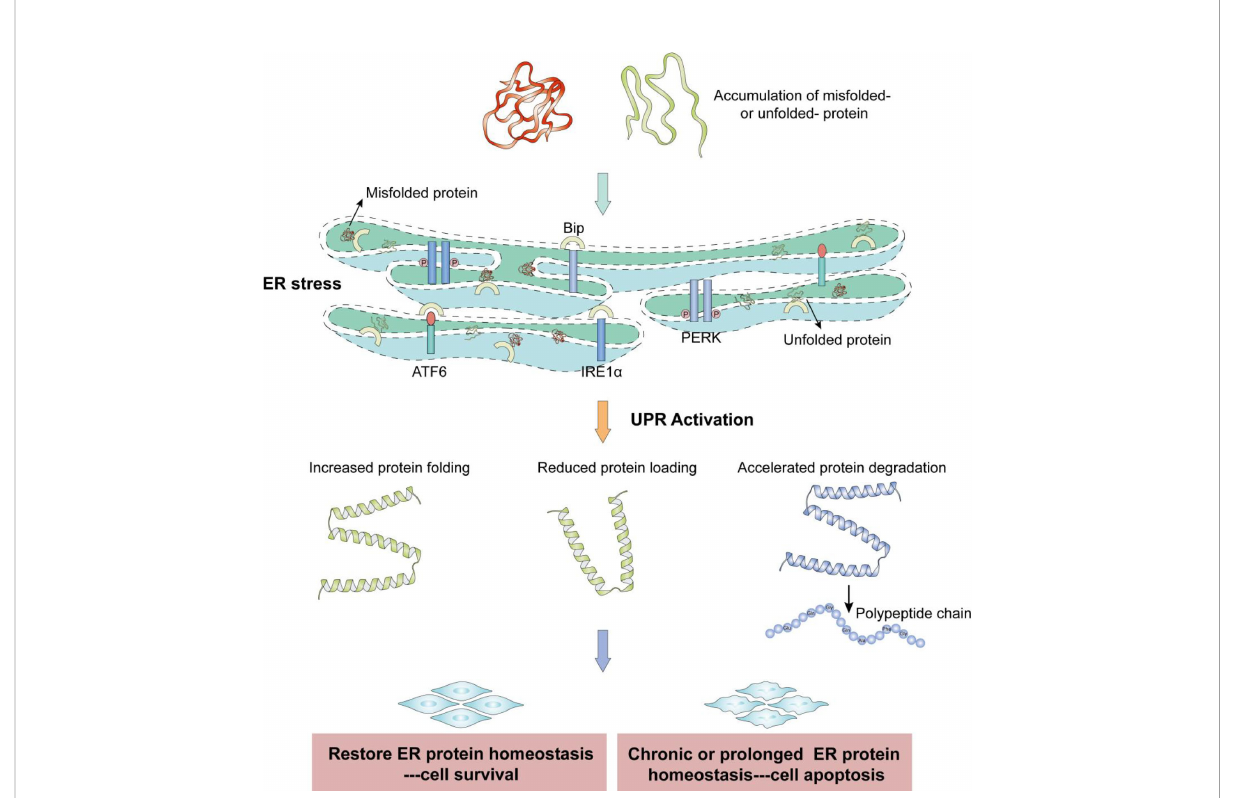
FIGURE 1 The unfolded protein response and pro-survival versus pro-death roles of endoplasmic reticulum stress. Accumulations of misfolded proteins and unfolded proteins cause ER stress. ER stress triggers the UPR, which is mediated by the three mammalian UPR transducers IRE1, PERK, and ATF6. Under conditions of ER stress, these proteins have various signal-mediated transcriptional effects that ameliorate ER stress and promote cell survival, but cell apoptosis occurs if ER protein homeostasis is not